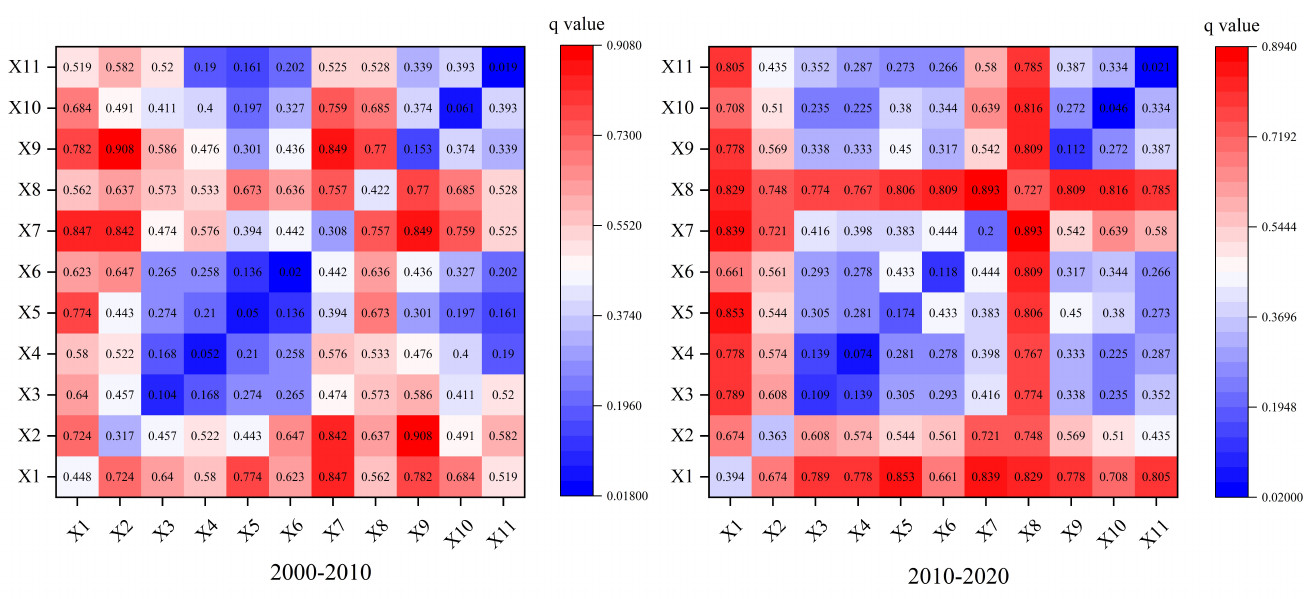
Figure 7. Interaction detection results in driving factors of cultivated land